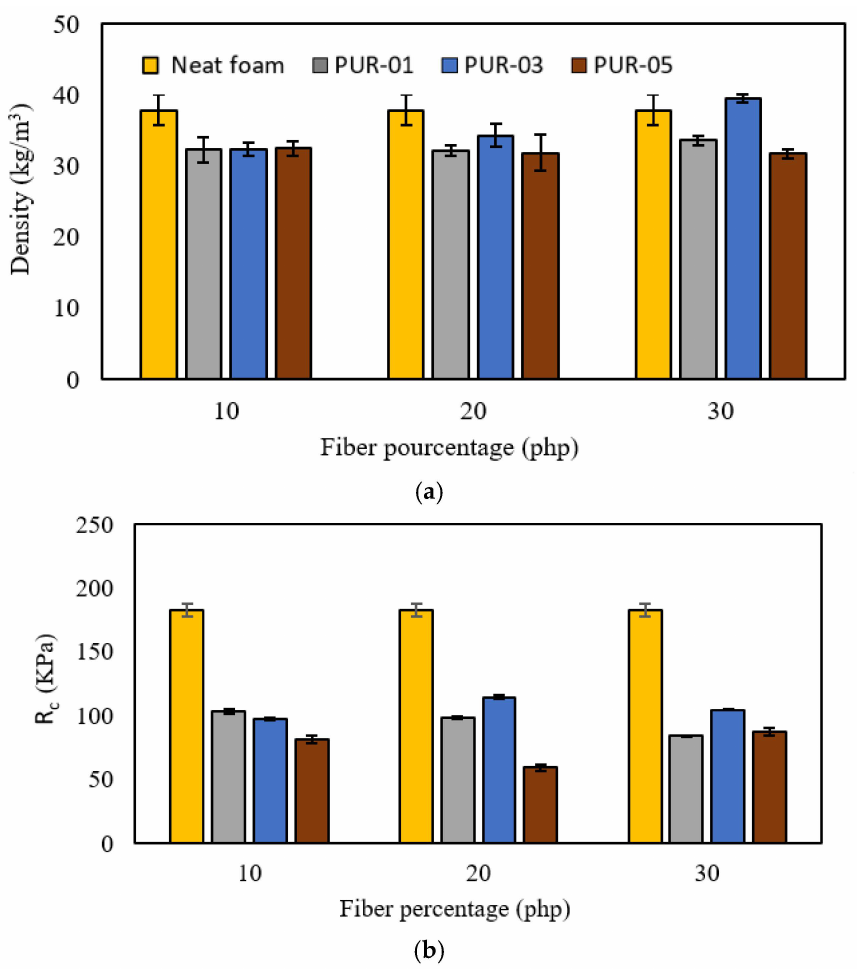
Figure 2. Effect of wood particles size and proportion on reinforced polyurethane foams properties; ( a ) density and ( b ) Compressive